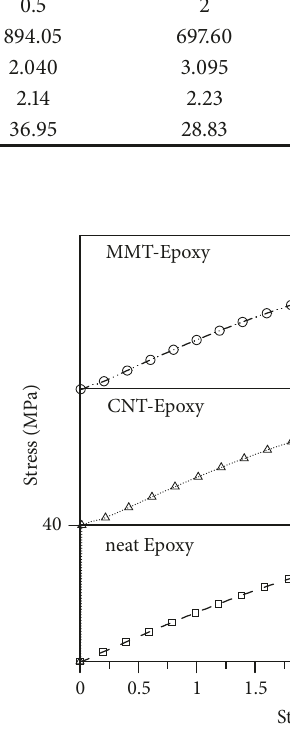
Figure 7: Stress strain graphs of neat epoxy and MMT/ SWCNT- epoxy in optimum fraction, conducted at 2 mm.min - 1 of cross head speed.